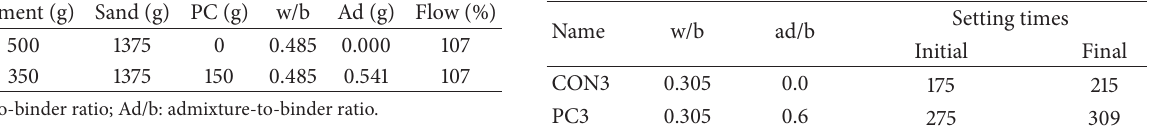
Table 4: Normal consistency and setting times of Portland and green